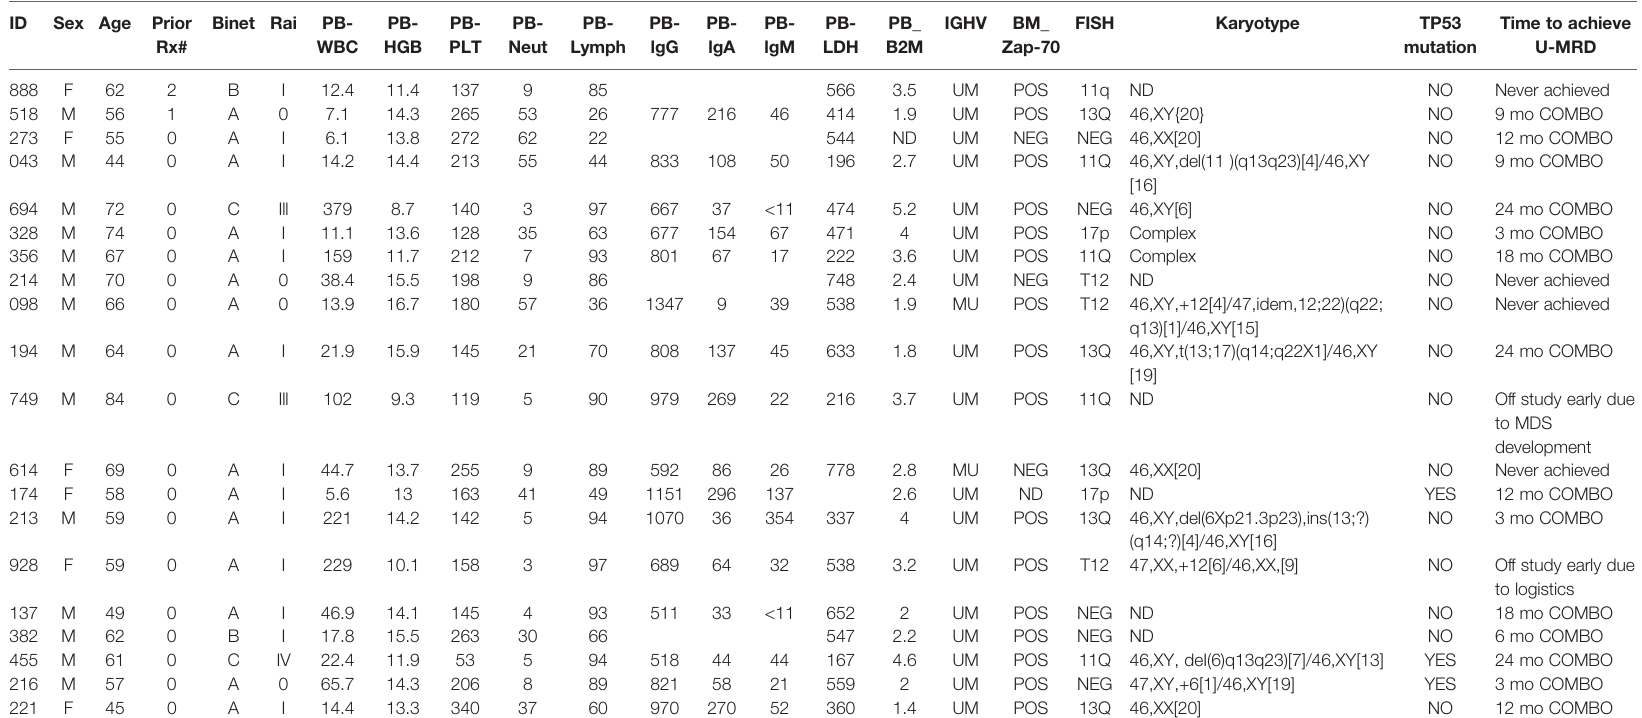
TABLE 1 | Patient